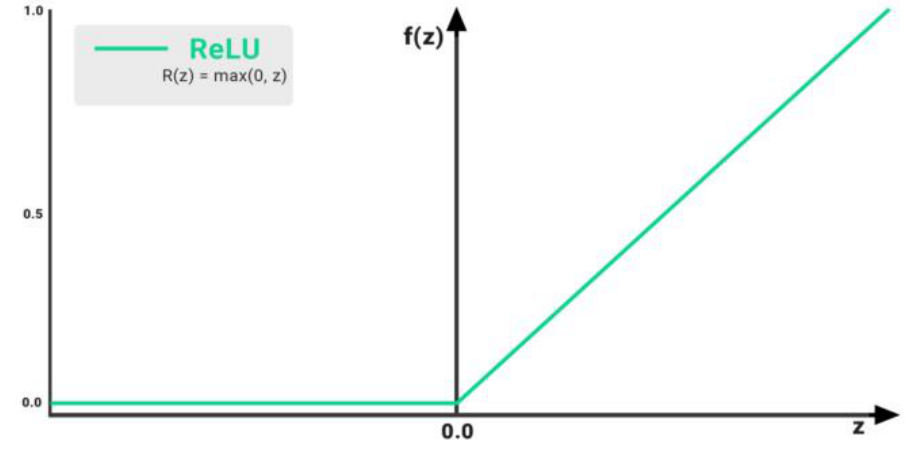
Figure 1. Role of Activation Function (AF).